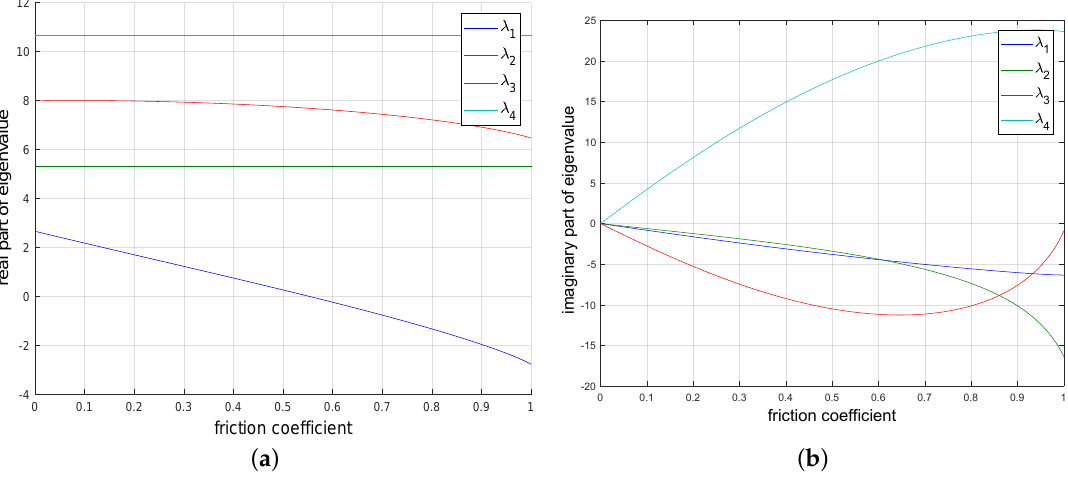
Figure 4. Longitudinal motion eigenvalues. ( a ) Real part of the eigenvalues; ( b ) imaginary part of the